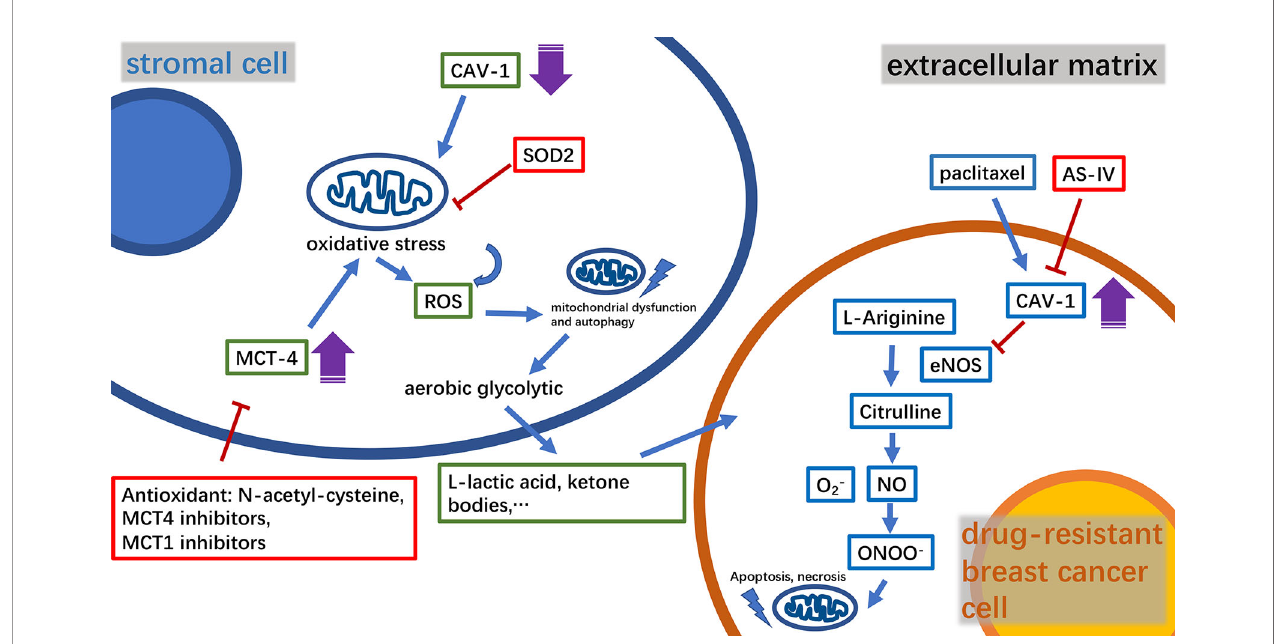
FIGURE 1 | A diagram of the relationship between key molecules in the microenvironment of drug-resistant breast cancer tumors and mitochondria, and the mechanism of the relevant drugs. CAV ‐ 1, caveolin ‐ 1; MCT4, monocarboxylate transporter 4; ROS, reactive oxygen species; SOD2, superoxide dismutase 2; AS ‐ IV, astragaloside IV; NO, nitric